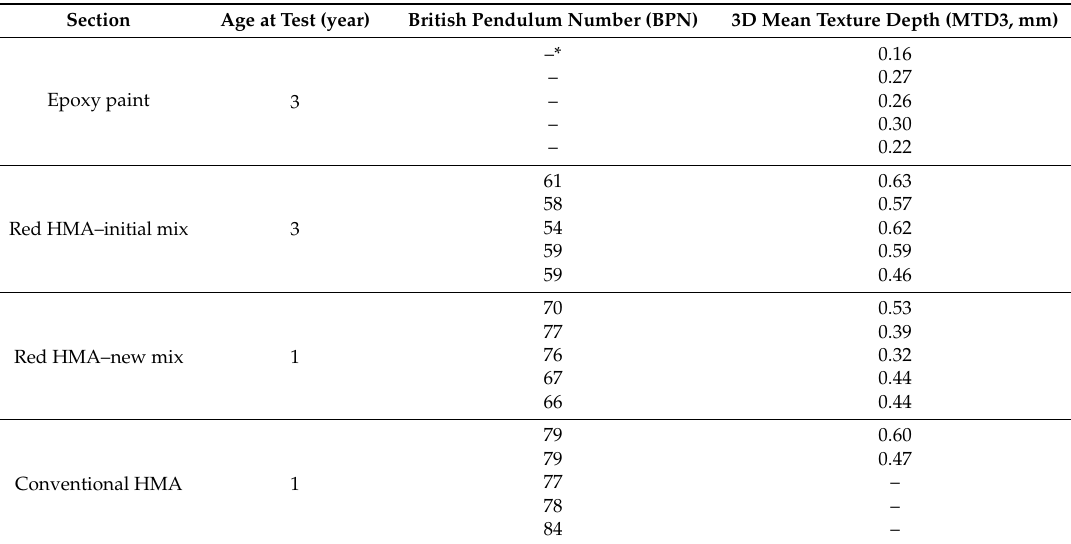
Table 3. Field test results.